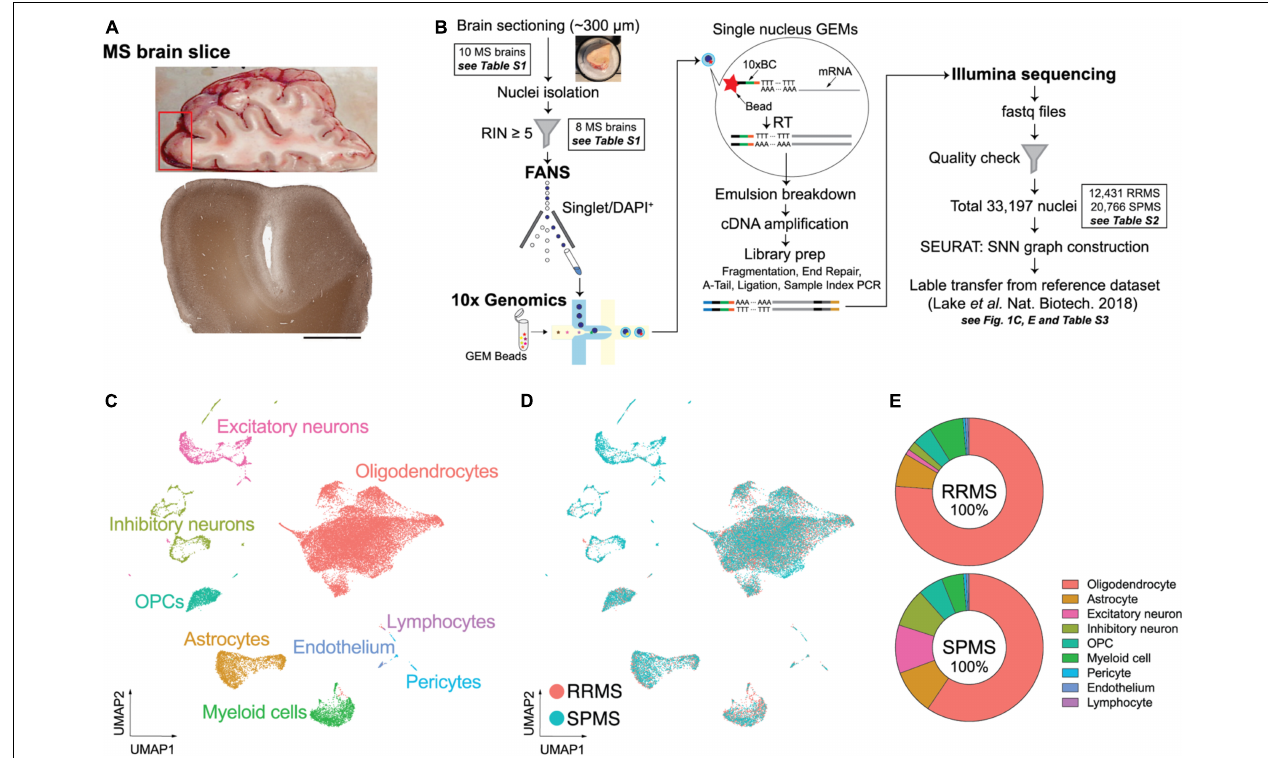
FIGURE 1 | Experimental approach of snRNA-seq and unbiased cellular identification in MS brains. (A) Macroscopic and standard immunohistochemical labeling for myelin-specific proteolipid protein (PLP) of a representative MS brain. (B) Experimental workflow. Nuclei were isolated from ∼ 300 µ m frozen MS brain sections by fluorescence-activated nuclear sorting (FANS) based on DAPI (4 (cid:48) ,6-diamidino-2-phenylindole) positivity. Brain samples with a RNA integrity number (RIN) ≥ 5 were processed for 10 × Genomics and snRNA-seq. (C) Unbiased cellular identification. Quality-control filtering identified a total of 33,197 nuclei from both RRMS and SPMS brains; these cells were then clustered using the shared nearest neighbor (SNN) clustering algorithm in the SEURAT package. The cell types were annotated based on the reference dataset of normal human brains (Lake et al., 2018) and are presented as a UMAP (uniform manifold approximation and projection) plot. Colors indicate specific cell clusters identified by SEURAT V.3.0. (D) UMAP plots for RRMS and SPMS cells. (E) Relative proportions of the nine cell types analyzed in the RRMS and SPMS brains (see details in Supplementary Table 3